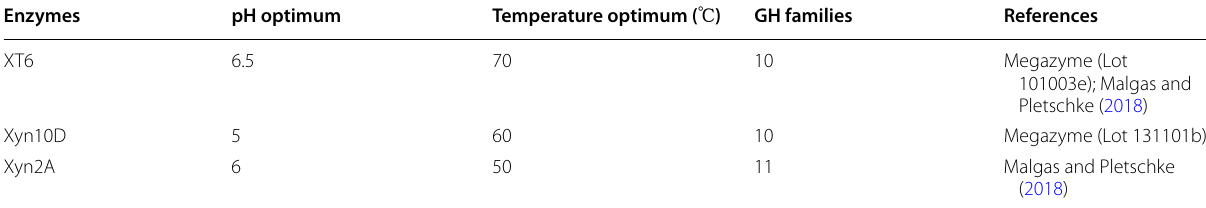
All xylanolytic enzymes displayed pH stability over a range of pH 5–8